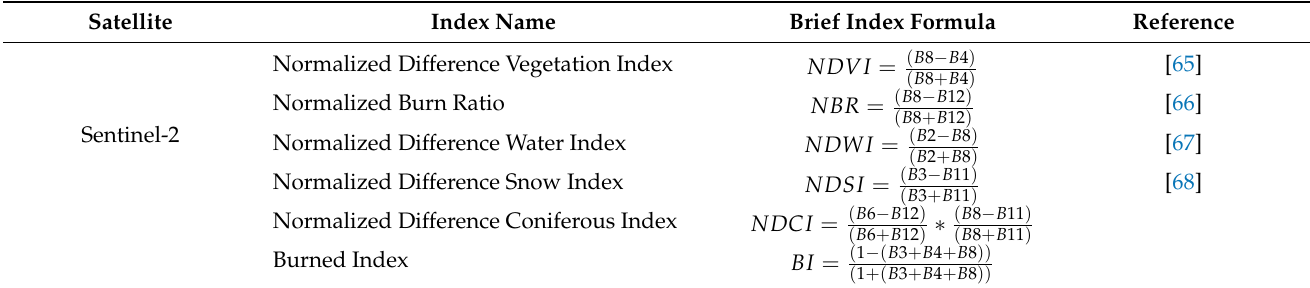
Table 4. Spectral indices used for land cover classification and change